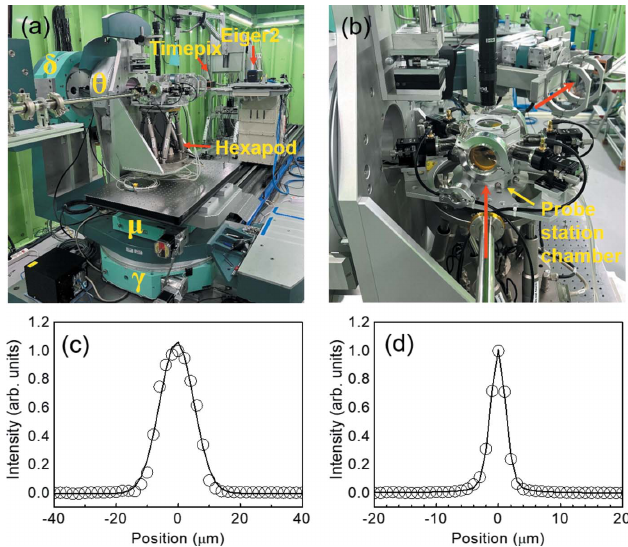
Figure 2 ( a , b ) Photographs of the multimodal X-ray probe station that includes the miniature probe station, hexapod manipulator and six-circle X-ray diffractometer. The X-ray diffractometer operates in ‘2 + 2’ mode to access Q space by combining motions of two detector circles and two sample circles. Panels ( c ) and ( d ) show intensity profiles at the focal point for estimating the focus size in the horizontal ( c ) and vertical ( d ) directions,